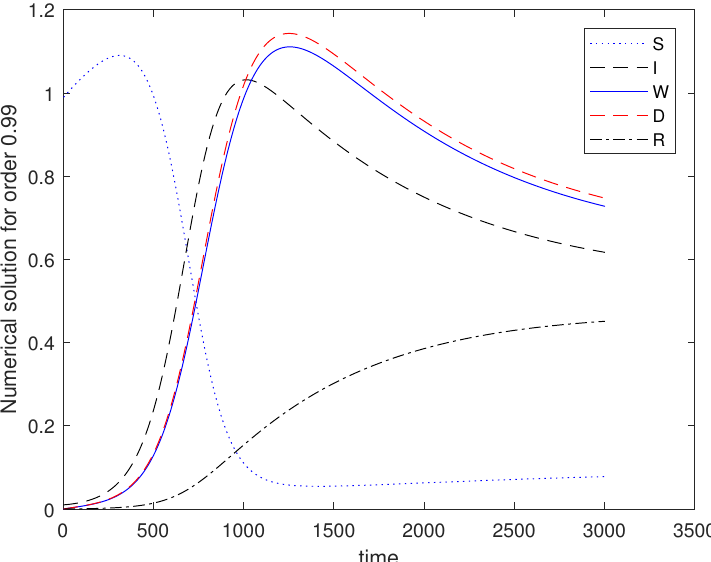
Figure 2. The computational results for the order 1 are compared with the solution for fractional order